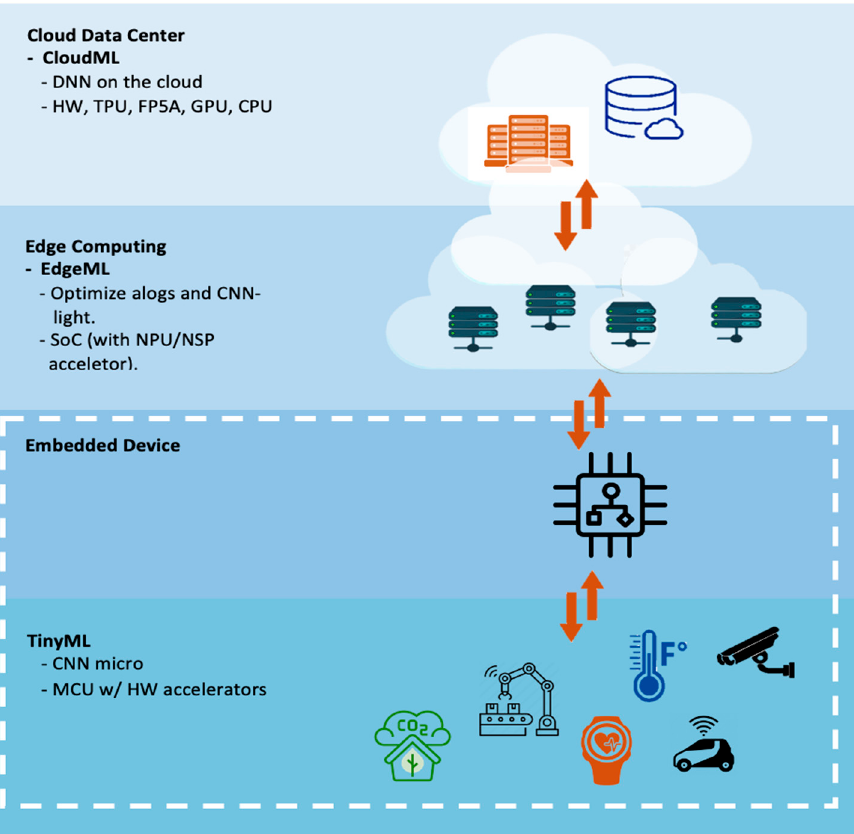
Figure 1. A framework of IoT applications with Cloud computing, Edge computing and TinyML.